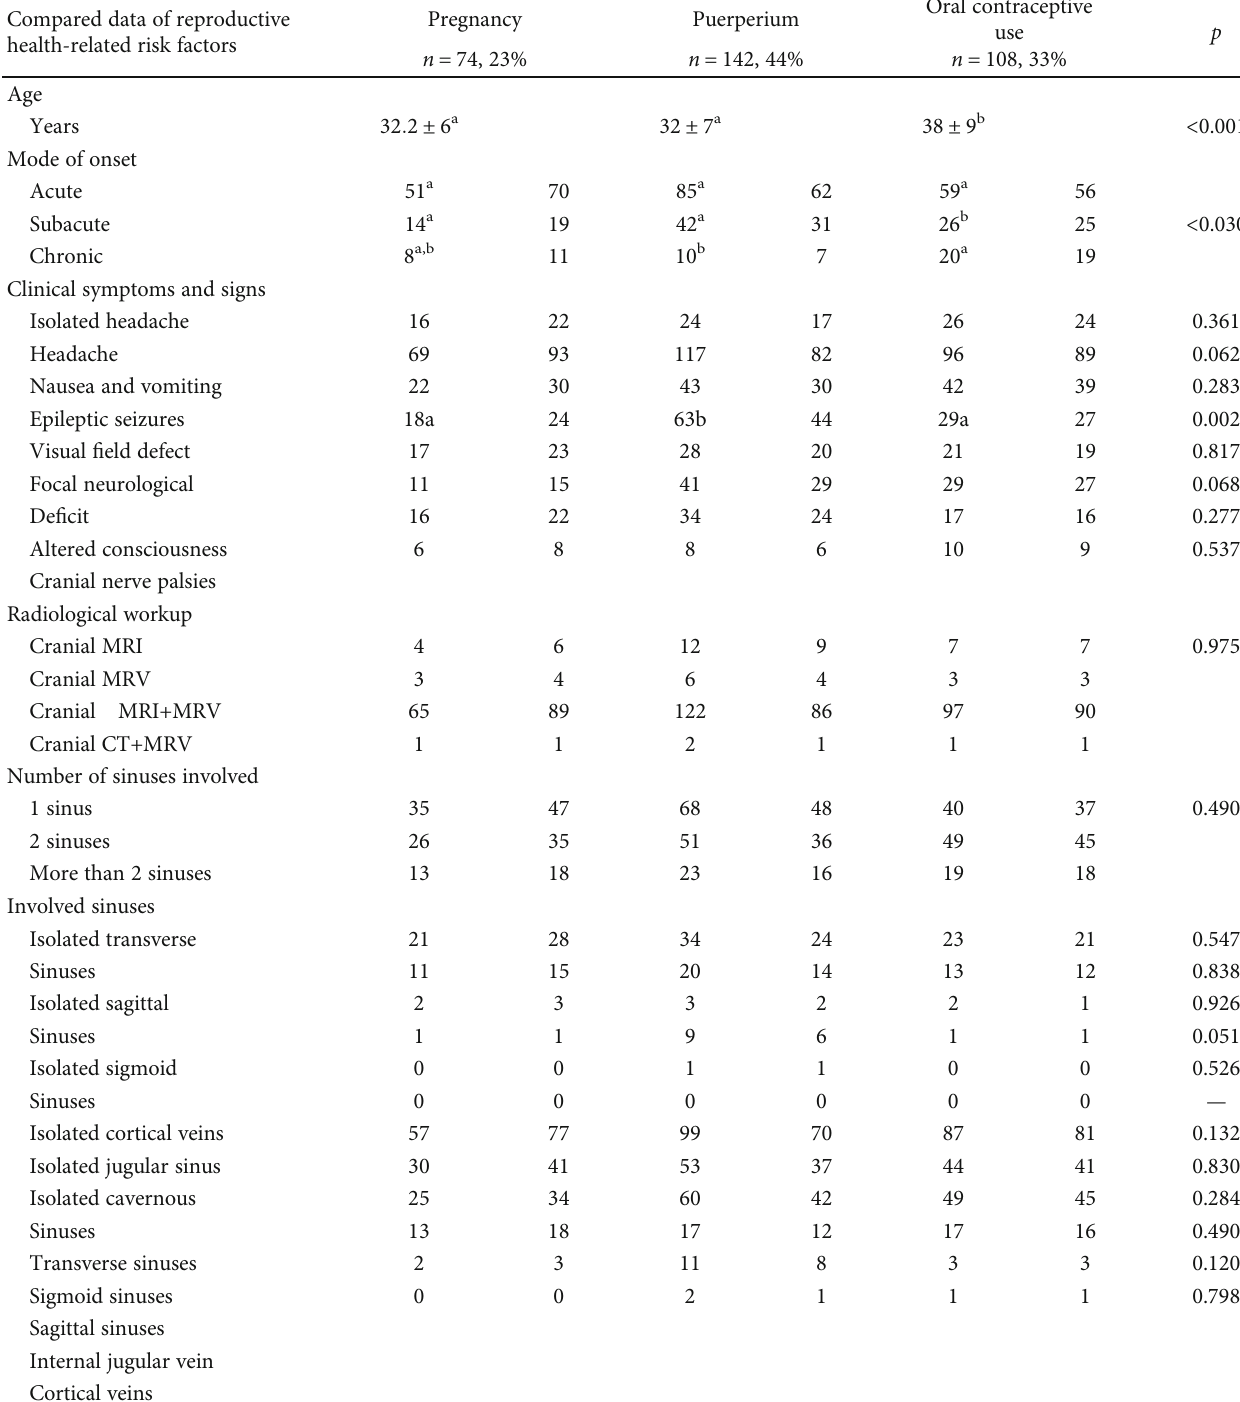
Table 3: Comparison of demographic and clinical characteristics of subgroups according to reproductive health-related risks. Compared data of